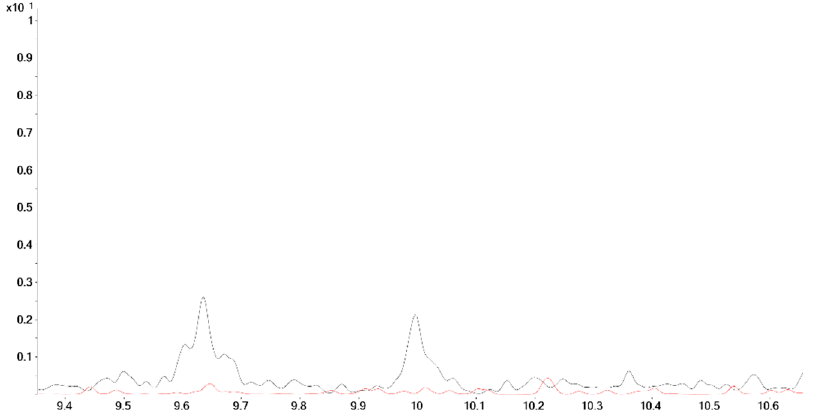
Figure 9. Chromatograms (MRM, m / z 450 → 345); black: positive urine sample after intake of methyltestosterone; red: synthesized substances.